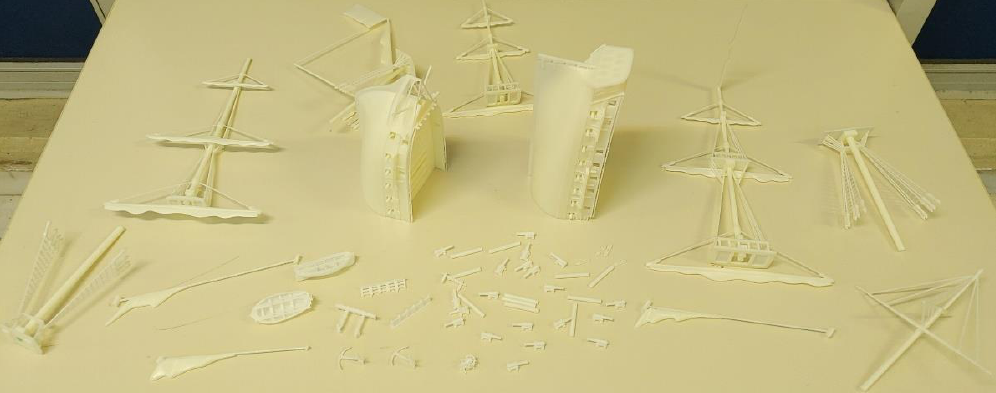
Figure 22 . Finished products after alcohol rinse and UV cure.